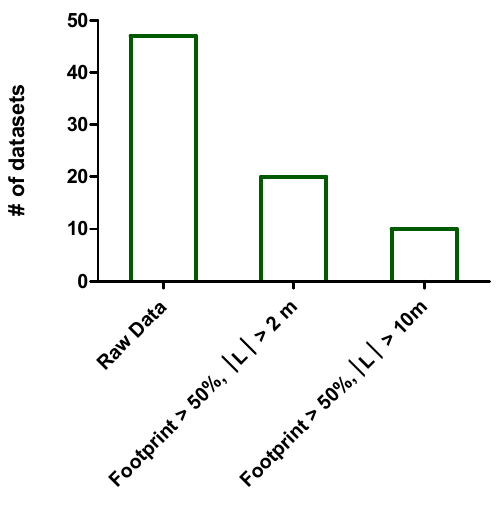
/Q from single source vs. number of path bLS